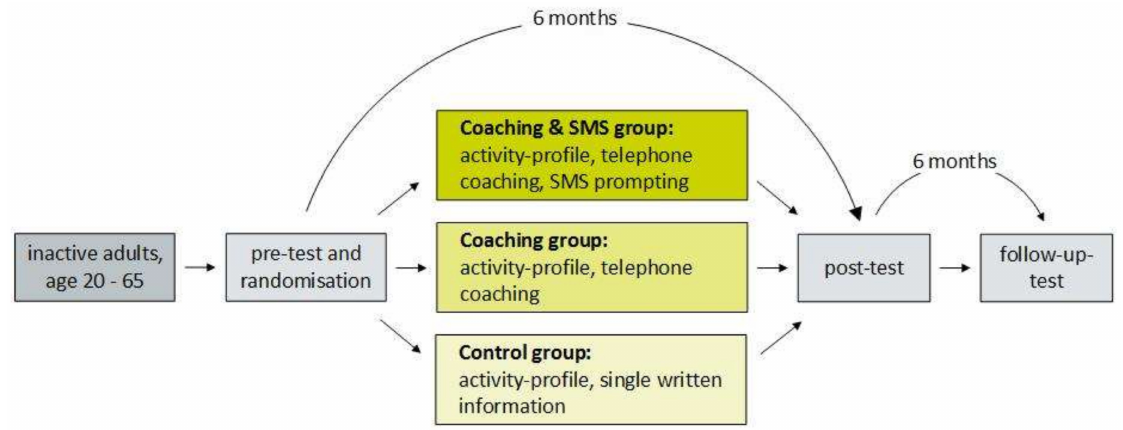
Figure 1. Study design. SMS: short message